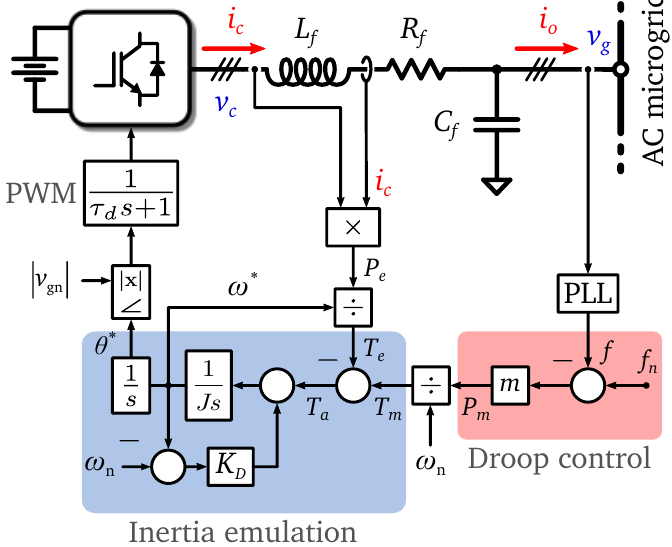
Figure 2. Virtual synchronous machine (VSM)-based primary control strategy for AC